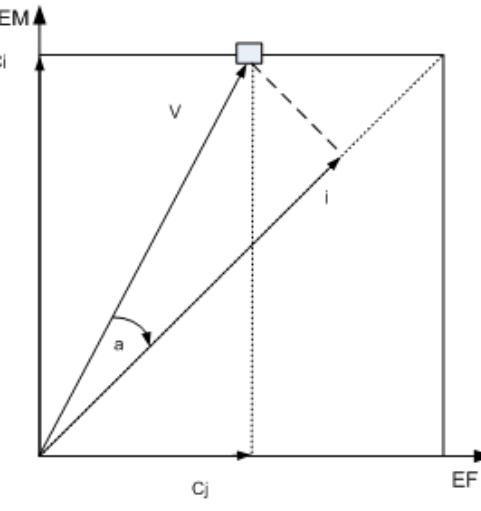
Figure 8 . Vector V (Ci;Cj) projected onto the